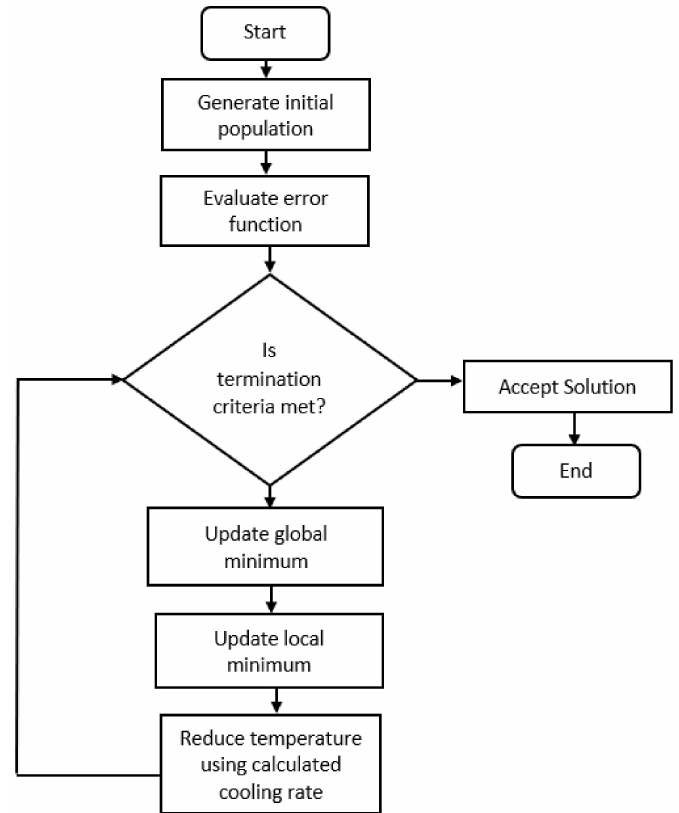
Figure 8. General Flowchart for particle swarm optimization (PSO) Algorithm.